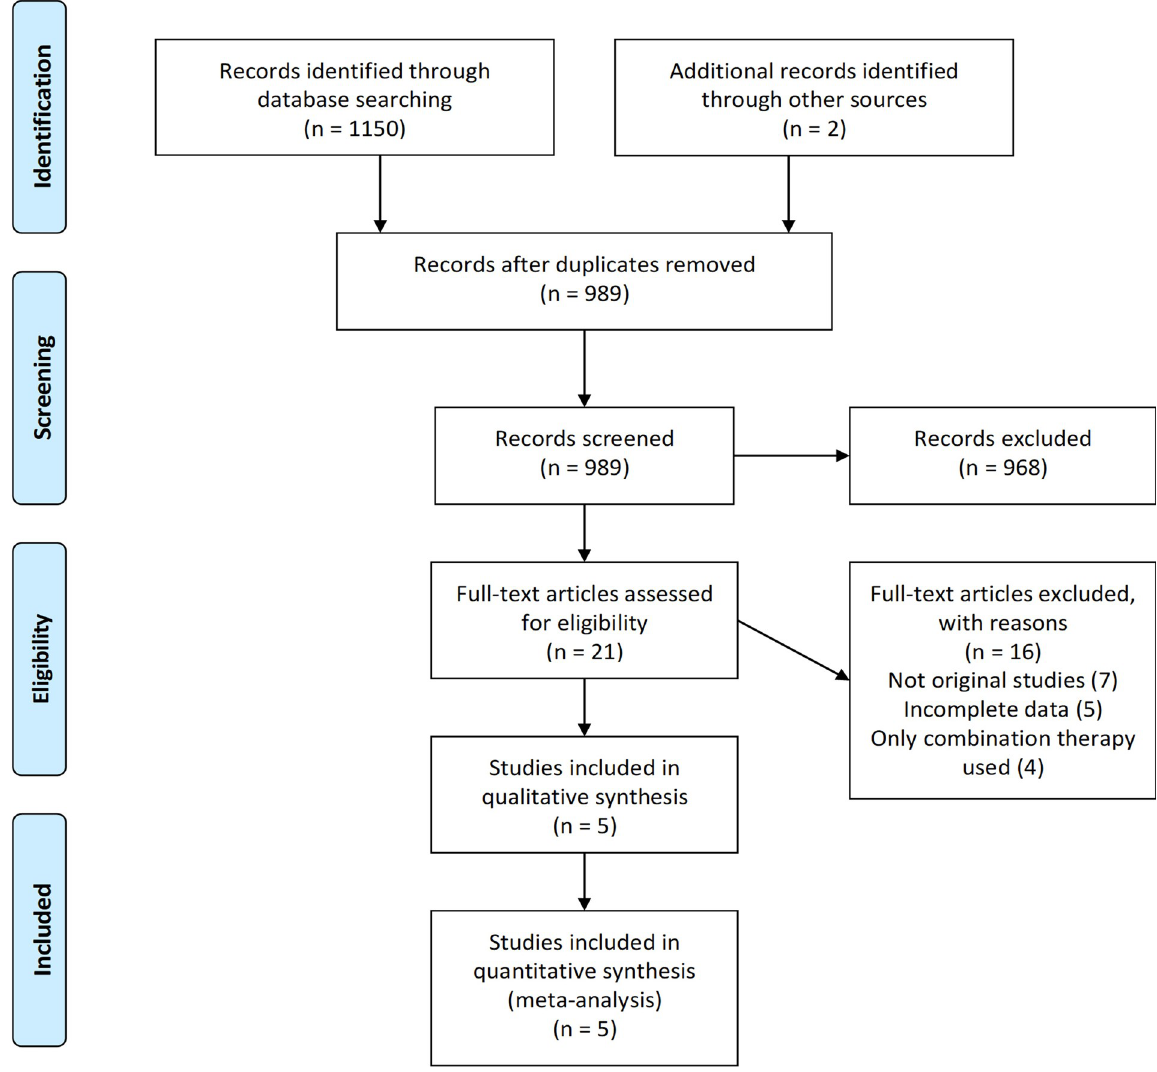
Fig 1. PRISMA flow